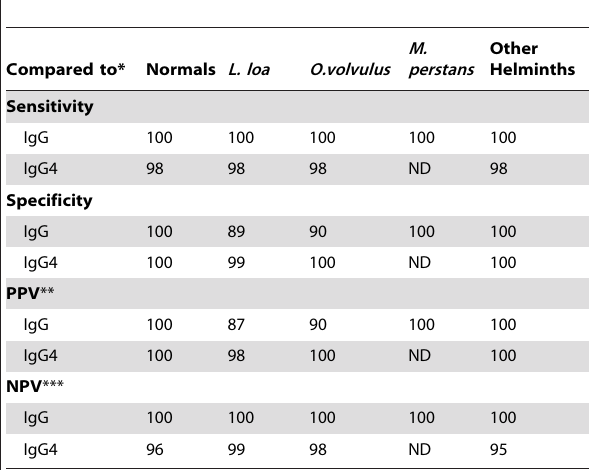
Table 2. Sensitivity and specificity of Wb123 IgG and IgG4 LIPS.